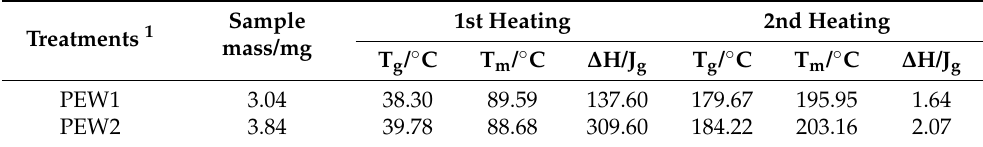
Figure 2. DSC scans of biodegradable containers made from pork skin gelatin, walnut shells, and eggshells. Table 2. Analysis of the effect of seal integrity of DSC sample pan on thermal transitions of biodegrad- able container of pork skin gelatin, walnut shells, and